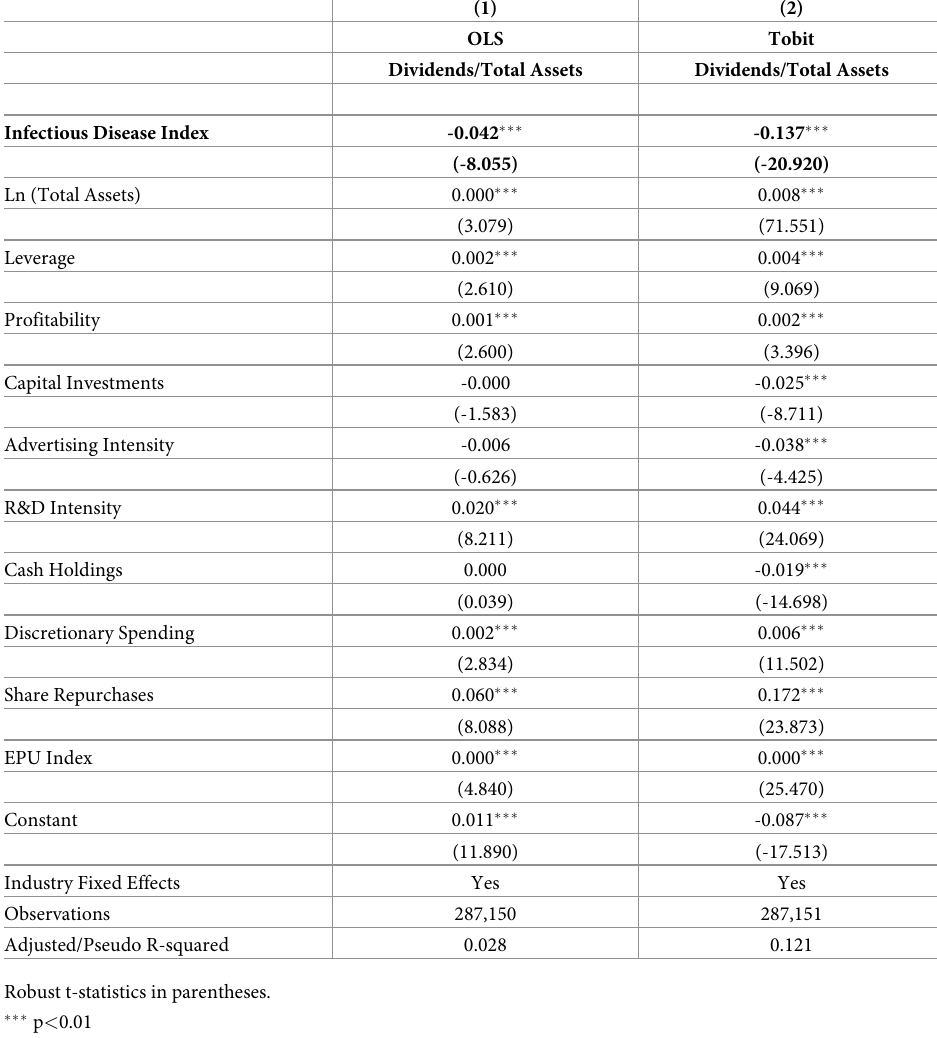
Table 6. Entropy balancing. Our measure of disease-related uncertainty is the infectious disease equity market vola- tility developed by Baker et al. (2020) [9]. Using sophisticated textual analysis, Baker et al. (2020) [9] search for news articles related to infectious diseases and equity market volatility. A higher fraction of these news articles to all articles in each time period signifies a higher level of market uncertainty that can be ascribed to infectious diseases. For ease of interpretation, we have the infectious disease equity market volatility index divided by